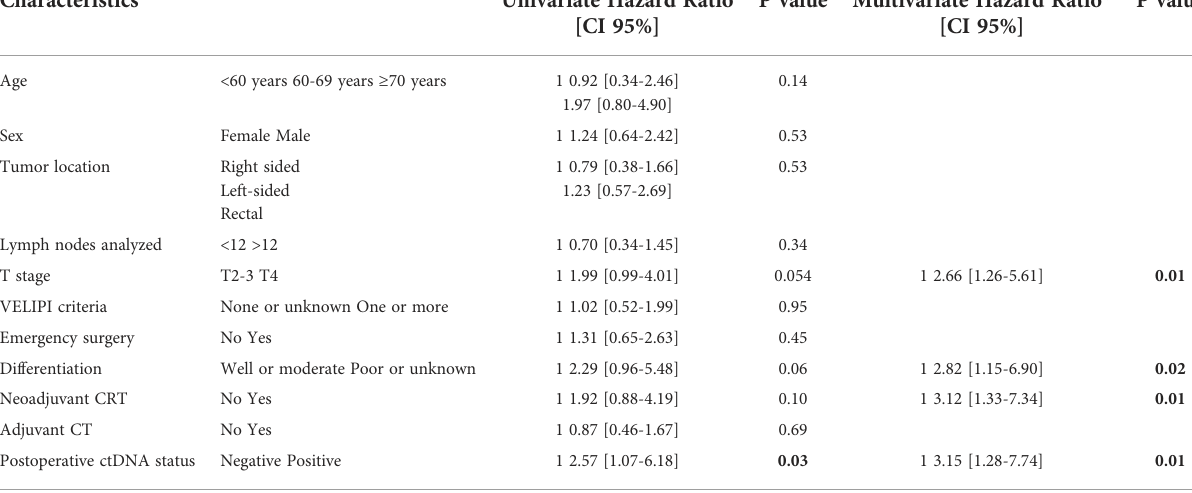
*Multivariate Cox model contains variables with a p value less than 0.1 in univariate analysis. † VELIPI criteria include vascular, lymphatic and/or perineural invasion. CRT, chemoradiotherapy; CT, chemotherapy; ctDNA, circulating tumor DNA. Bold values correspond to p values lower than 0.05.